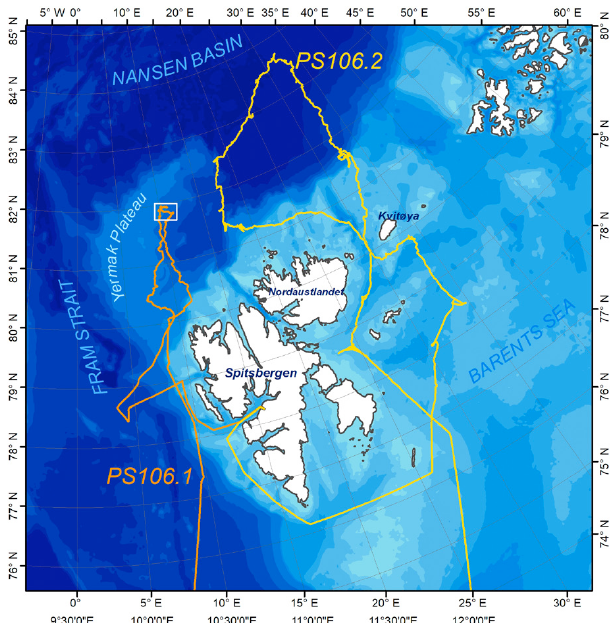
Figure 1. Overview of the main expedition area of the Polarstern cruises PS106.1 and PS106.2. Figure taken from Macke and Flores (2018).